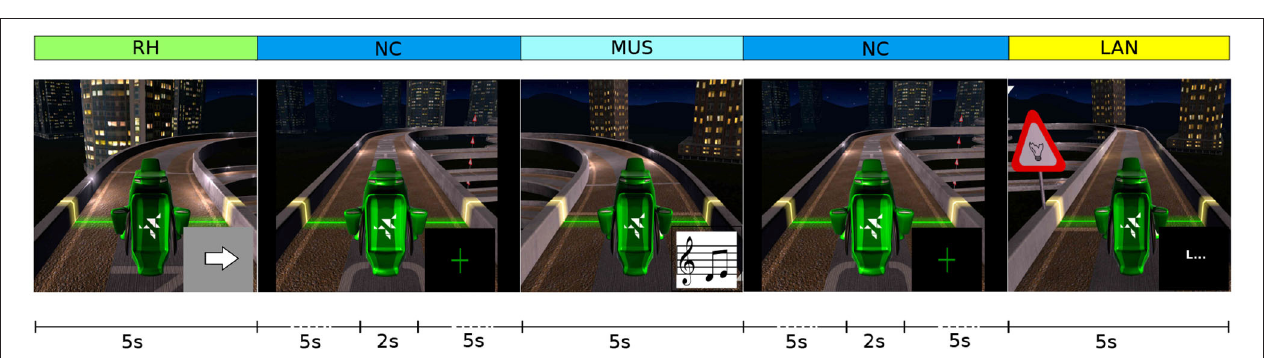
FIGURE 4 | Experimental 4-class paradigm applied in the training phase. The user had to perform each control task (RH, MUS, LAN) for 5 s. Each task was associated to an image made by combining the task icon with an image extracted from the game at the proper time instant. The rest interval, corresponded to the no control task (NC), has a total duration of 12 s. After 5 s of this rest interval, a green cross appeared on the screen for 2 s to improve the concentration of the pilot.